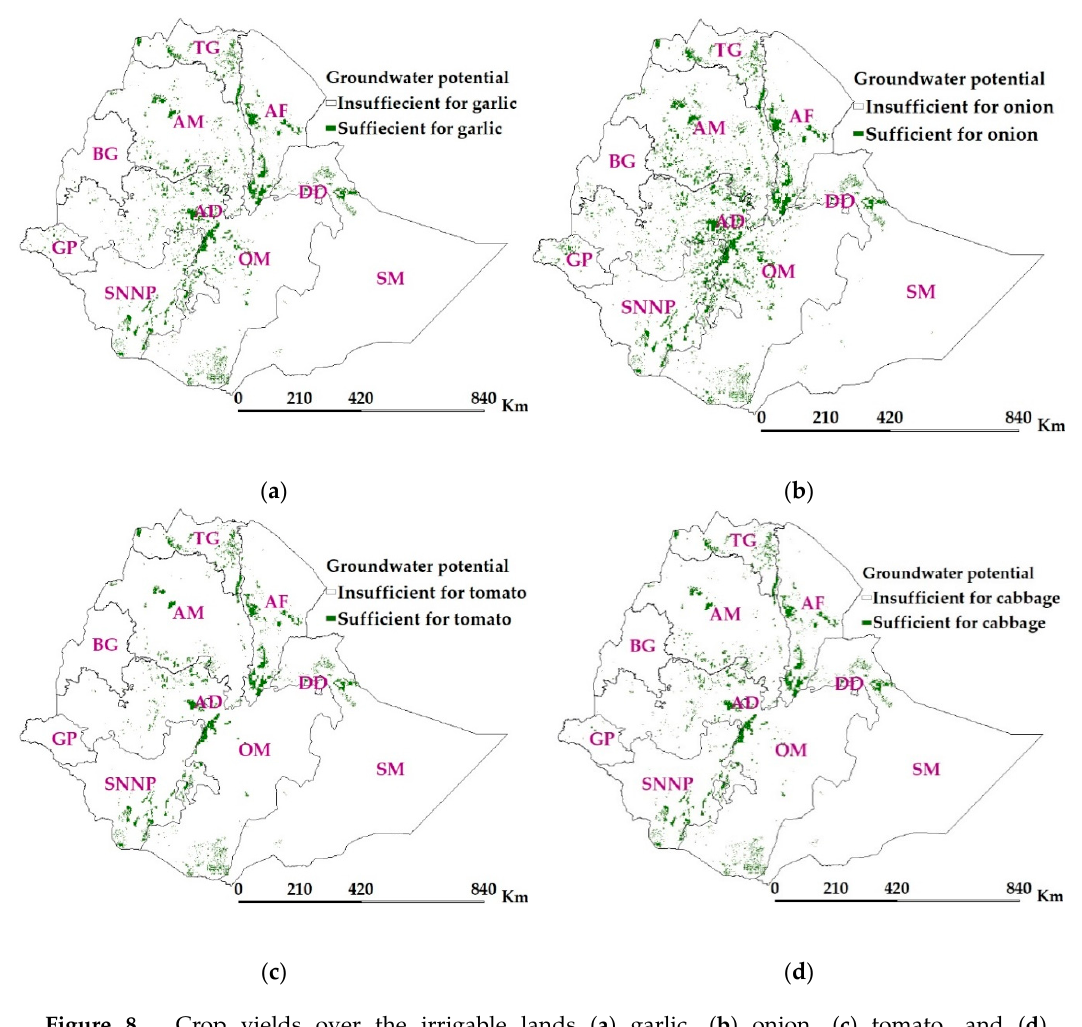
Figure 8. Crop yields over the irrigable lands ( a ) garlic, ( b ) onion, ( c ) tomato, and ( d ) cabbage. Abbreviations in the map are administrative regions (TG—Tigray, AM—Amhara, AF—Afar,